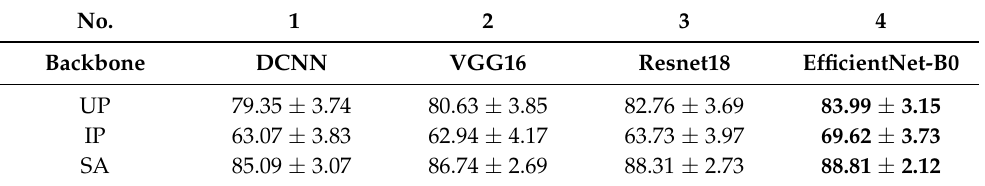
Table 3. Overall accuracy (OA, %) of the proposed method for the target HSIs with different deep networks as the